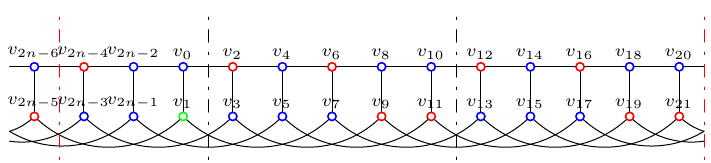
Figure 7. Segment of f in Case 2.1 in Lemma 7.